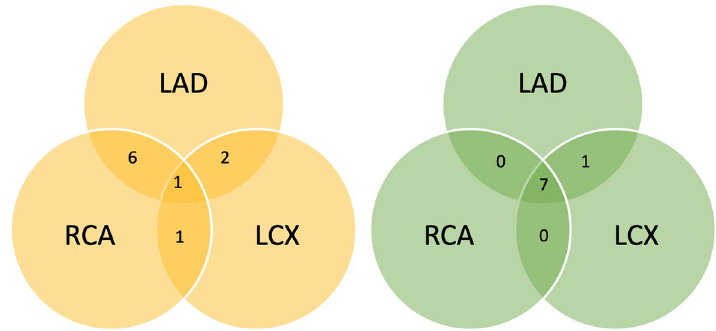
Figure 4. Venn diagram of the 8 multi-vessel-disease cases as defined by fSENC (left) and coronary angiography/bypass operation